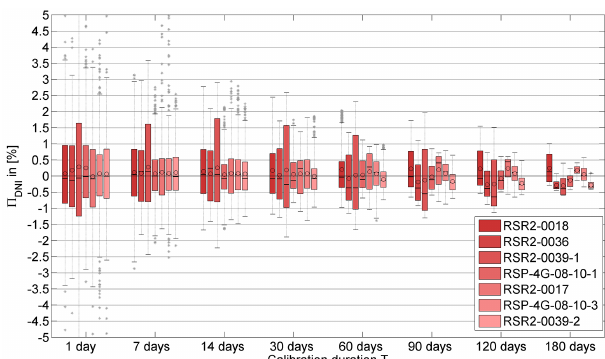
Figure 2. DLR2008: distribution of (cid:53) DNI depending on calibra- tion duration for seven data sets. (cid:53) DNI represents the deviation of calibration results from a long-term calibration for